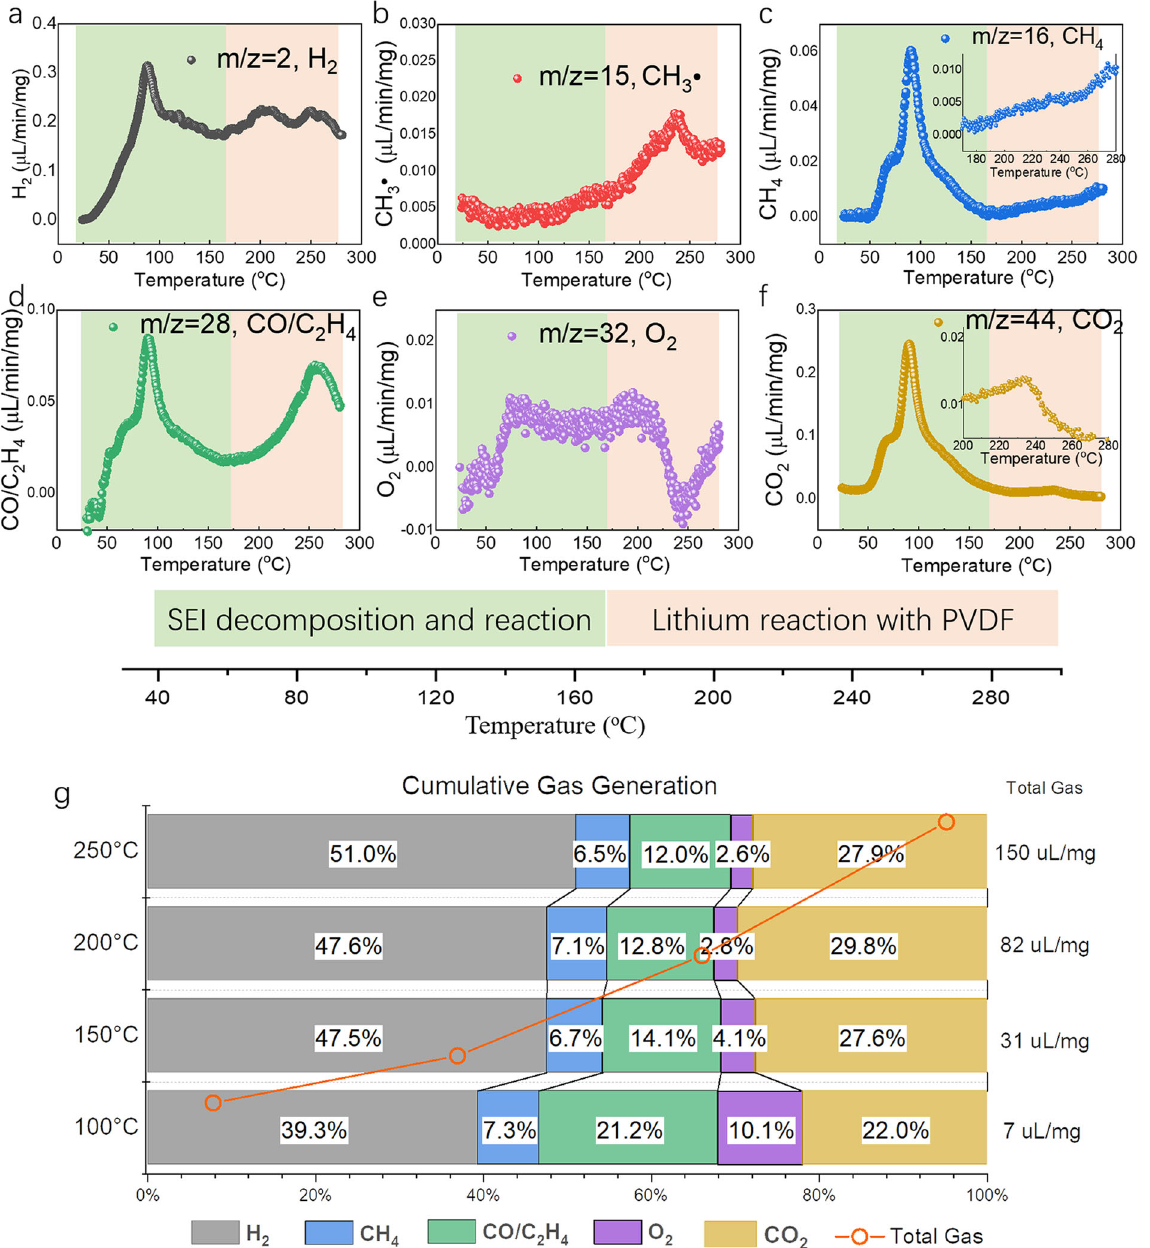
Fig. 3 The in situ gas release of lithiated graphite anode during heating. a – f The in situ monitoring of H 2 , CH 3 , CH 4 , CO/C 2 H 4 , O 2 , and CO 2 gas evolution during the heating of the lithiated graphite anode. g The quantitative analysis of the cumulative gas ratio at 100, 150, 200, and 250